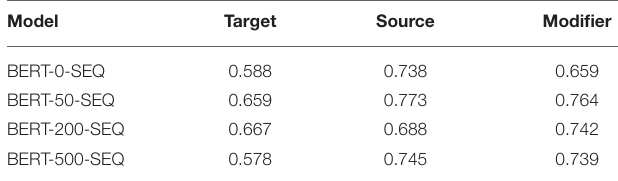
TABLE 8 | F 1 of all VA chunks per